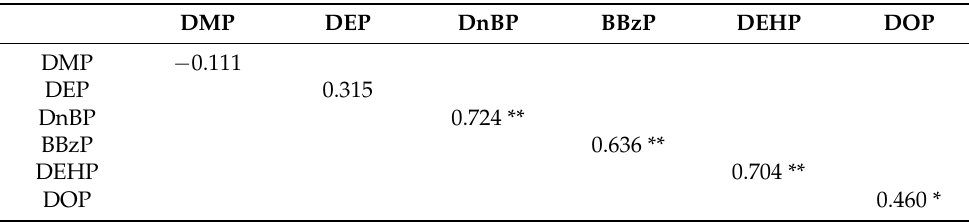
Table 2. Correlation coefficients between phthalates in table dust and bedside dust by Spearman’s rank correlation